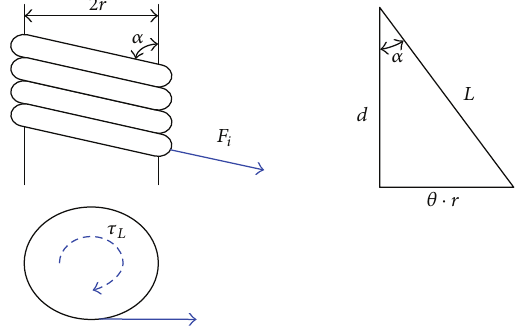
Figure 3: Geometric configuration of a single twisted strand.